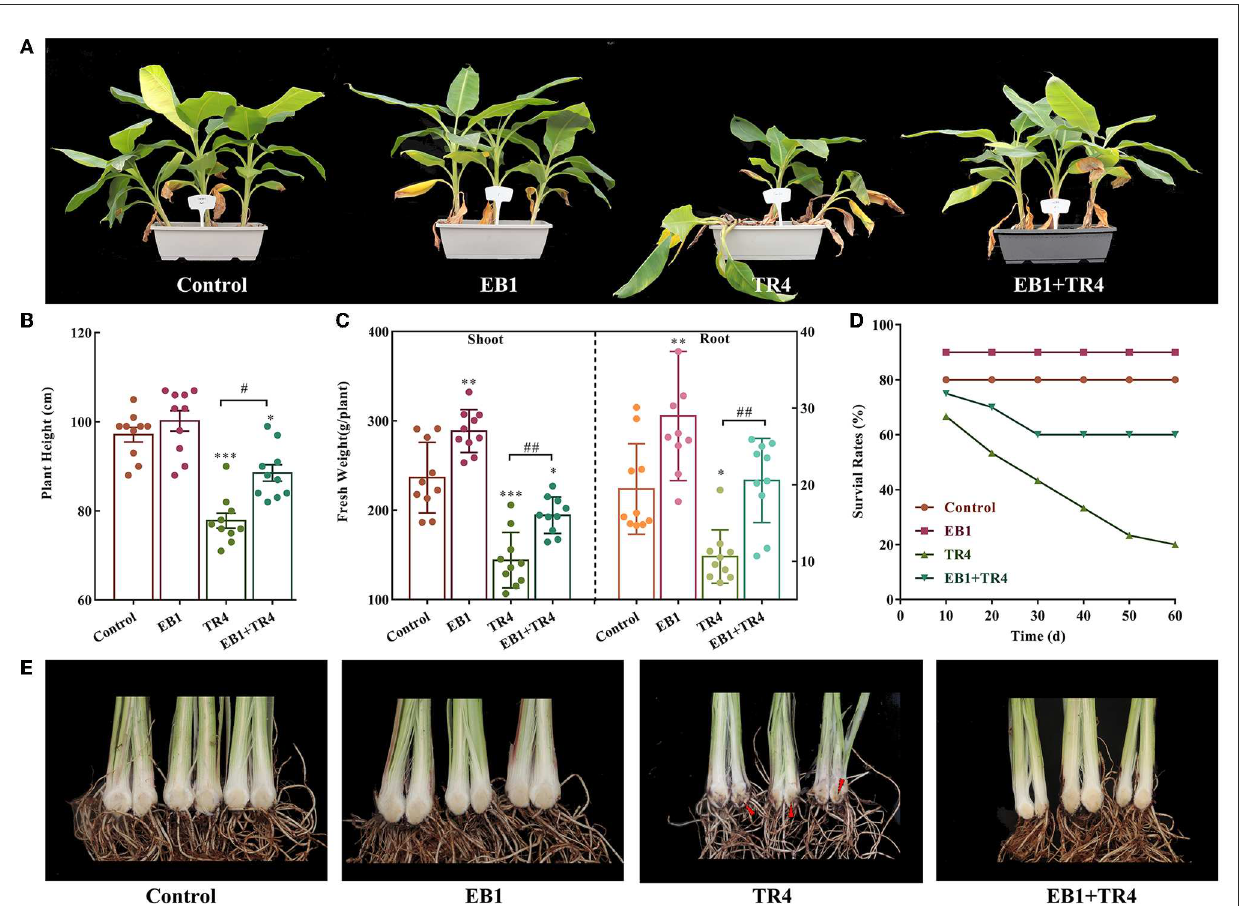
FIGURE4 Strain EB1 enhances Fusarium wilt resistance and promoted banana growth in the pot experiment. Control, no inoculation; EB1, inoculation with EB1 only, TR4, inoculation with TR4 only; EB1 + TR4, inoculation of EB1 prior to Foc treatment. (A) Phenotypes of acclimatized banana plants after being primed with EB1 at the rooting stage of tissue culture plantlets. (B–E) Plant height (B) , biomass of shoots and roots (C) , survival rates (D) , and severity of Fusarium wilt of acclimatized banana plants under different treatments (marked by red arrow heads) (E) . All data are expressed as the mean ± SD of at least 10 replicate samples. * p < 0.05, ** p < 0.01, and *** p < 0.001 indicate significant differences between the treatment groups and control group. # p < 0.05 and ## p < 0.01 indicate significant differences between treatment